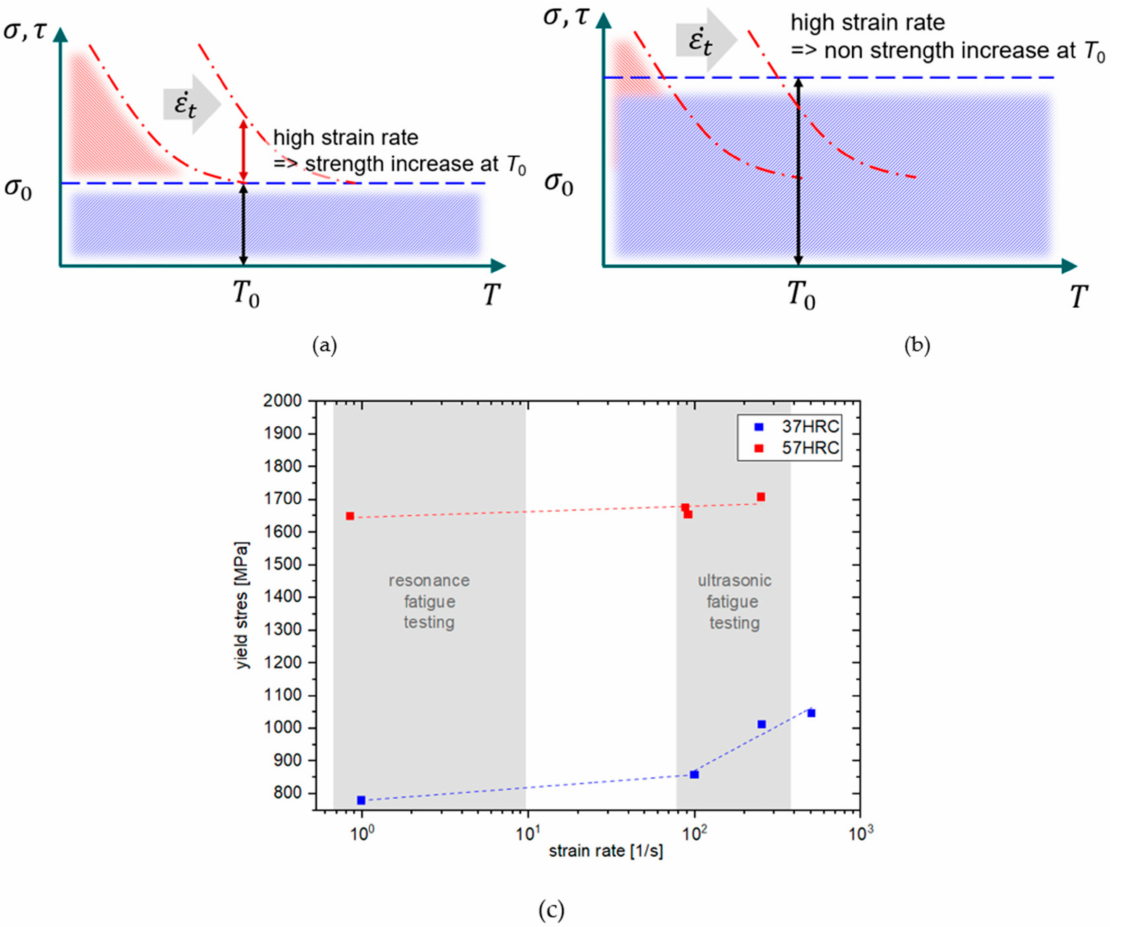
Figure 14. Schematic sketch of the temperature dependence of the critical shear/yield stress: red lines: the thermally-activated contribution (increases with increasing strain rate), blue lines: the athermal contribution in ( a ) moderate-strength alloys, and ( b ) high-strength alloys; and ( c ) yield stress vs. strain rate for the two 50CrMo4 steel